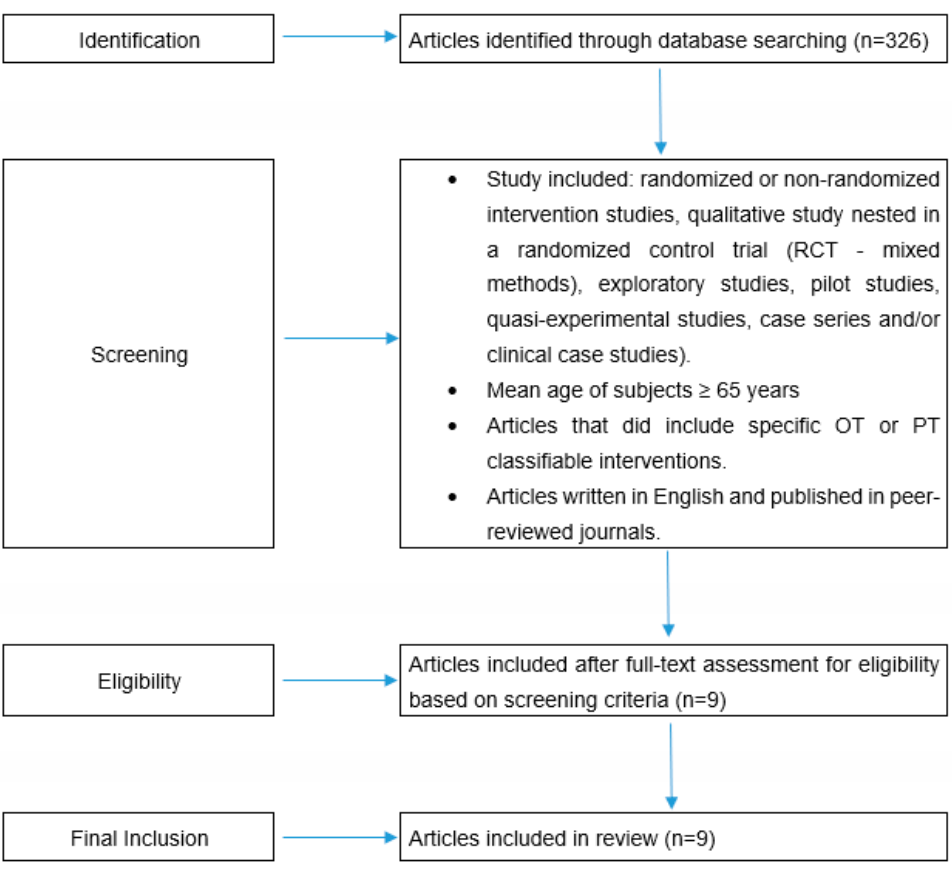
Figure 1. Study flow chart.